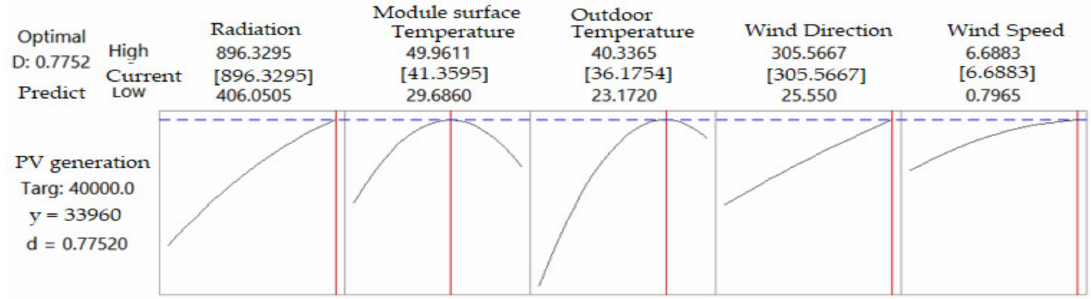
Figure 18. The individual effect of factors on solar PV generation system.